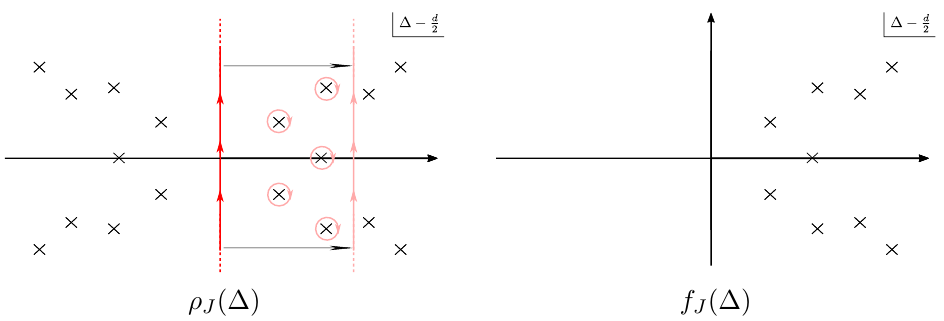
Figure 7 . Analytic structures of the spectral density ρ J (∆) and the spectral amplitude f J (∆) . Left : to all orders in perturbation theory, the spectral density of the late-time four-point function is also a meromorphic function thanks to the relation to EAdS discussed in section 3. We can therefore perform the same manipulation as in EAdS to produce a discrete sum over conformal blocks. Non-perturbatively, however, we currently do not have an argument for such an analytic property. Right : perturbative calculations often lead to a slightly different representation in which ρ J is replaced with a non-symmetric function f J . In examples in perturbation theory, we can check that f J (∆) is analytic on the left half plane except for possible poles corresponding to the dS